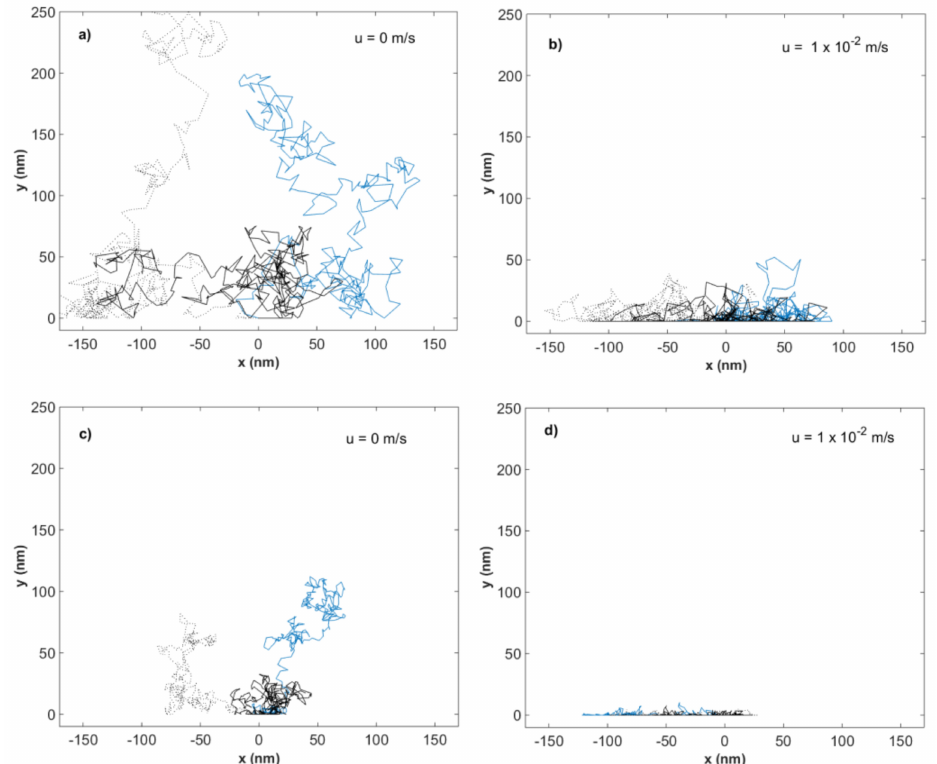
Figure 2. Simulated particle trajectories for 5 nm gold particles in water at flow velocities ( a ) 0 m/s and ( b ) 1 × 10 − 2 m/s and 28 nm Φ X174 bacteriophages in water at flow velocities ( c ) 0 m/s and ( d ) 1 × 10 − 2 m/s. Each line represents one particle